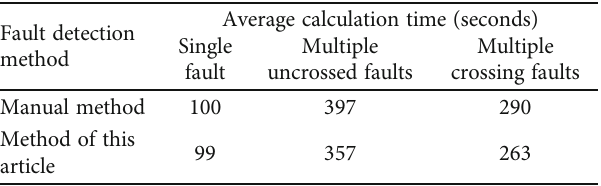
Table 2: Comparison of the total number of detected faults. Fault